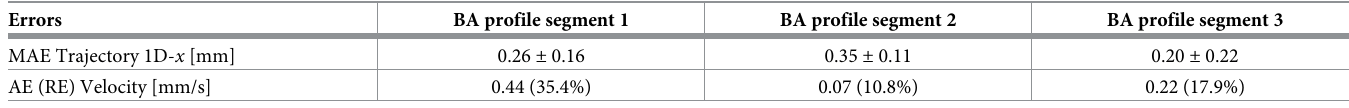
Table 2. The mean absolute error (MAE) for the distance in x -direction for the BA profile is given with its standard deviation (SD). The AE along with the RE of the velocity using the 3D regression line between t M 1 and t M 2 is also